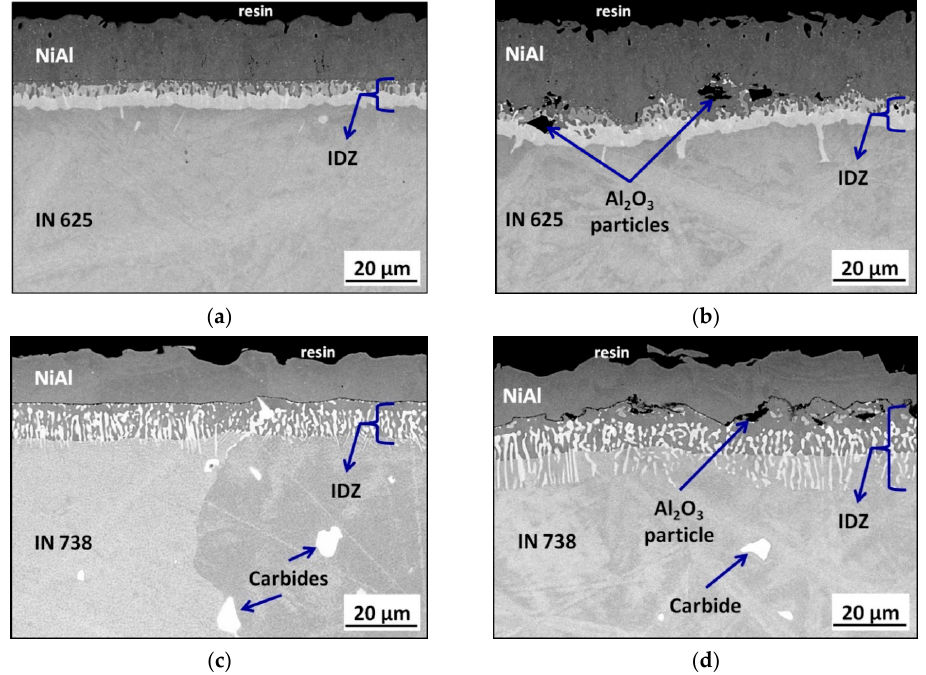
Figure 4. SEM / back scattered electron (BSE) images showing cross-sections of aluminide coatings formed on: ( a ) Ground IN 625, ( b ) grit-blasted IN 625, ( c ) ground IN 738, and ( d ) grit-blasted IN 738 in the as-received